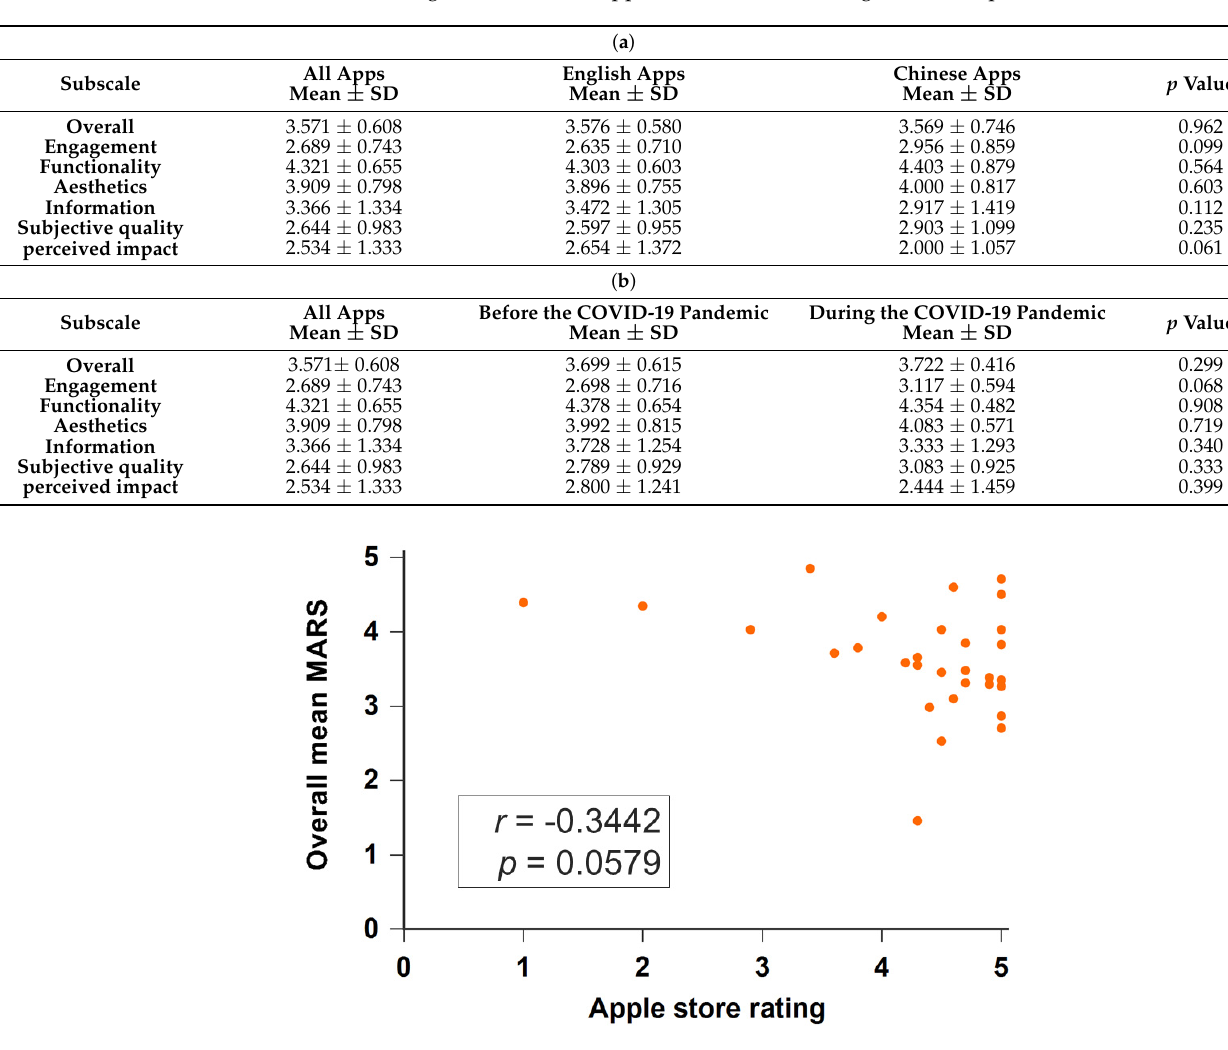
Figure 3. Scatter plots of the MARS score and Apple store rating. Table 2. Quality of ADRD applications measured by the Mobile Application Rating Scale (MARS) in ( a ) all and English vs. Chinese apps, ( b ) before and during COVID-19 pandemic. ( a )